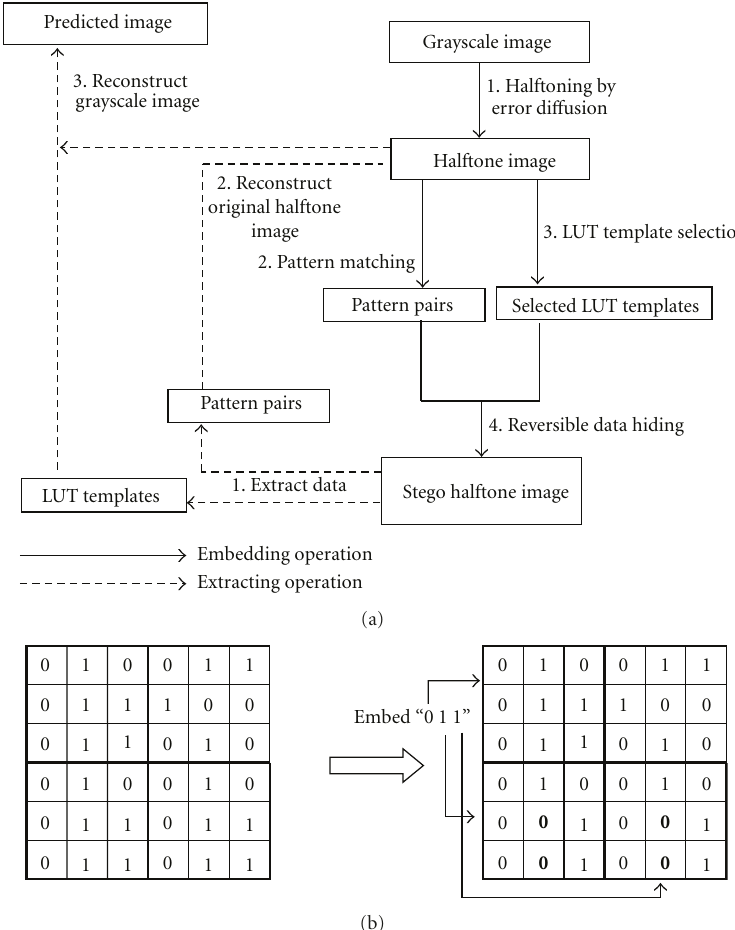
Figure 3: The embedding and extracting diagram and an example for the proposed method: (a) the embedding and extracting diagram of proposed method, (b) an example to illustrate the process of data embedding using pattern substitution.